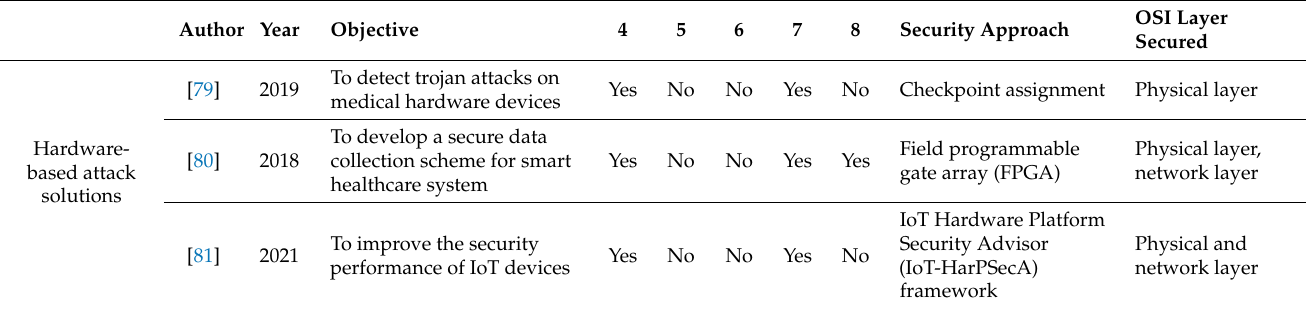
Table 4. Comprehensive analysis of existing state-of-the-art work for security solutions in smart healthcare